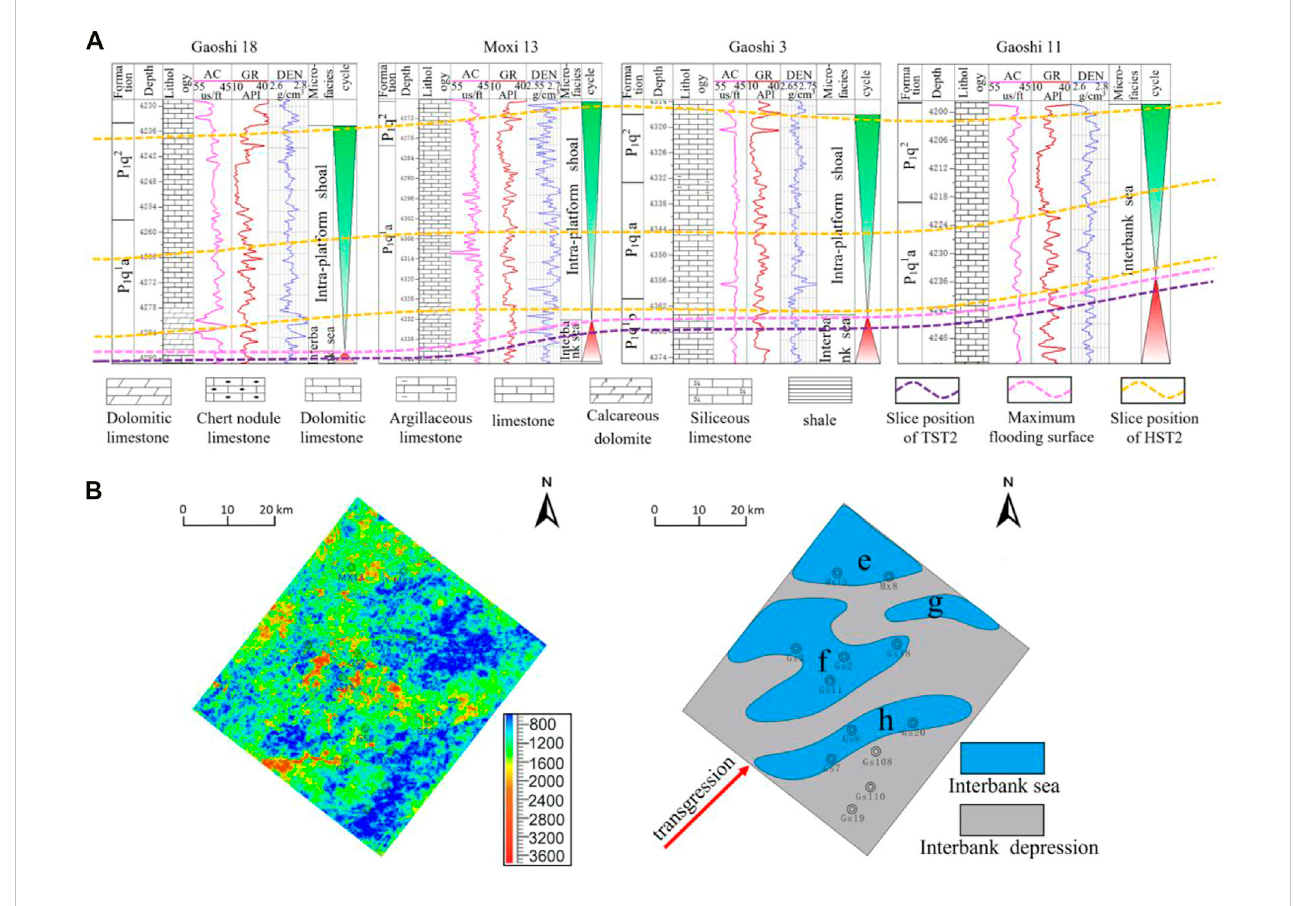
FIGURE 13 (A) LogcurveandsedimentarymicrofaciesinterpretationdiagramofrepresentativewelllocationinSQ2period;; (B) logcurveofsurfacewelllocationand sedimentary microfacies interpretation diagram in SQ2